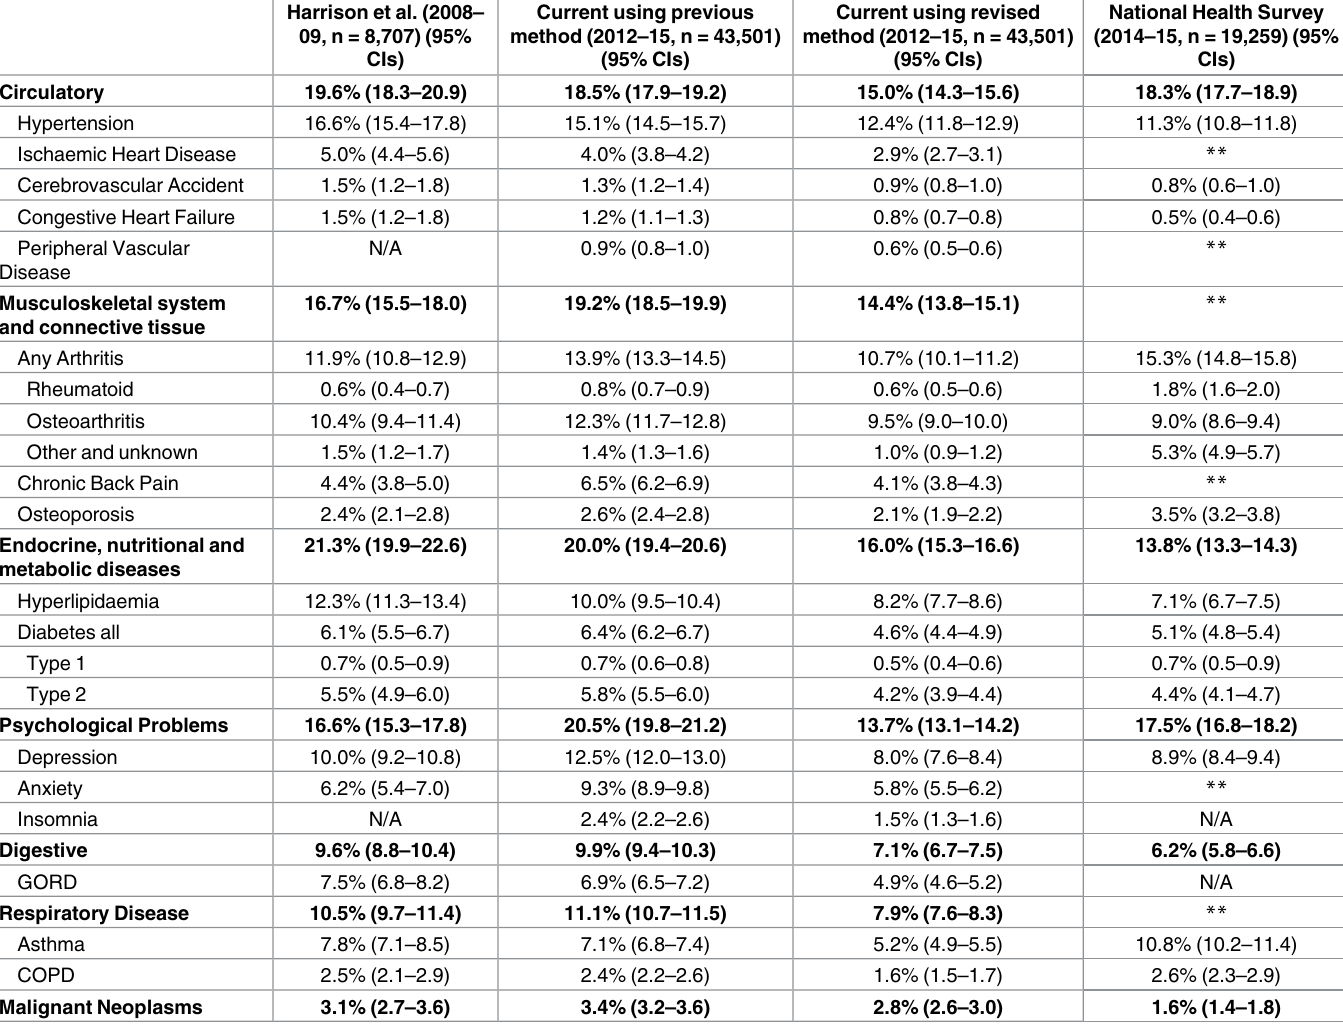
Table 4. Population prevalenceof common diagnosed chronic conditions and